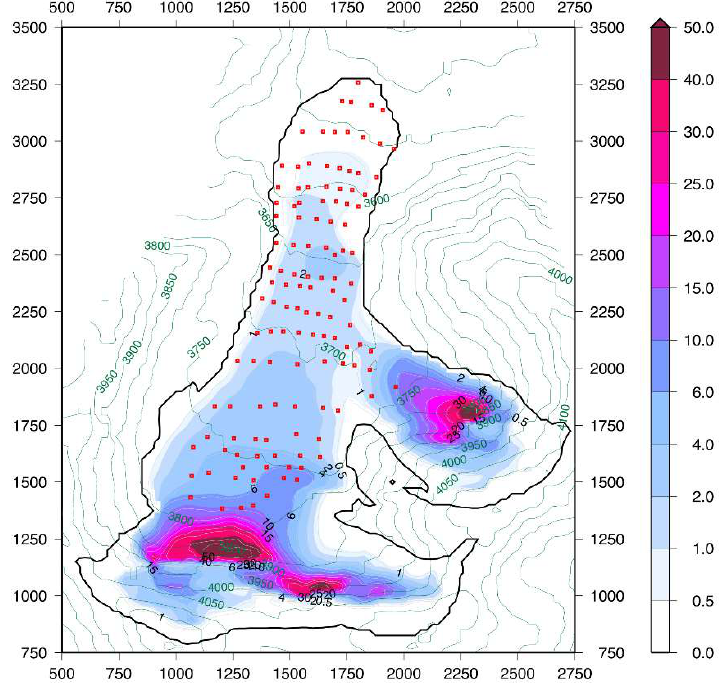
Figure 4. Modelled ice surface flow velocities at the Tuyuksu glacier (m year −1 ).